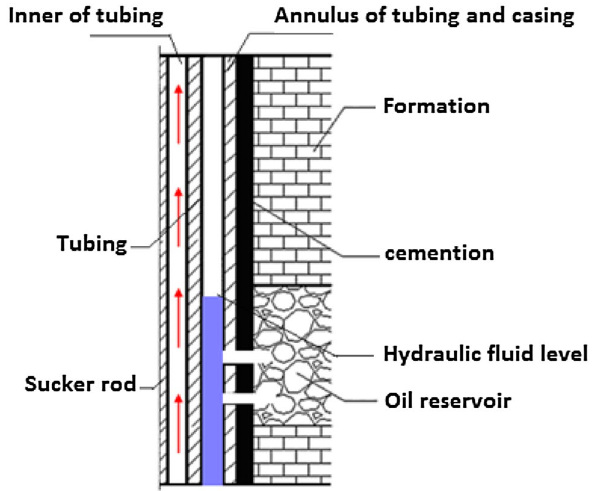
Fig. 2 Numerical physical model of producing